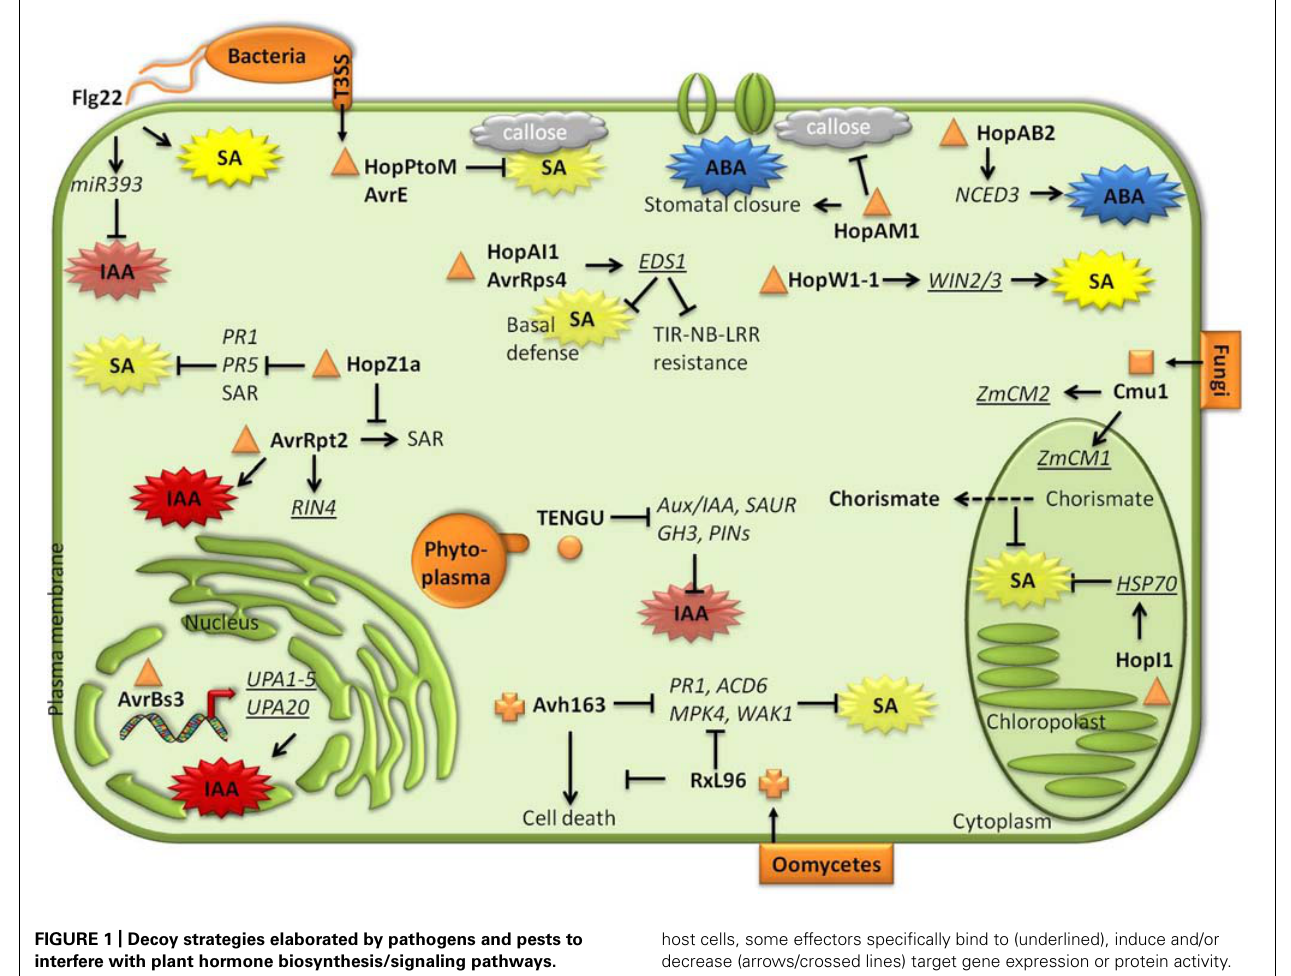
FIGURE 1 | Decoy strategies elaborated by pathogens and pests to interfere with plant hormone biosynthesis/signaling pathways. Phytopathogenic bacteria, phytoplasmas, fungi, and oomycetes secrete various effectors inside plant cells during infectious process. Once in the